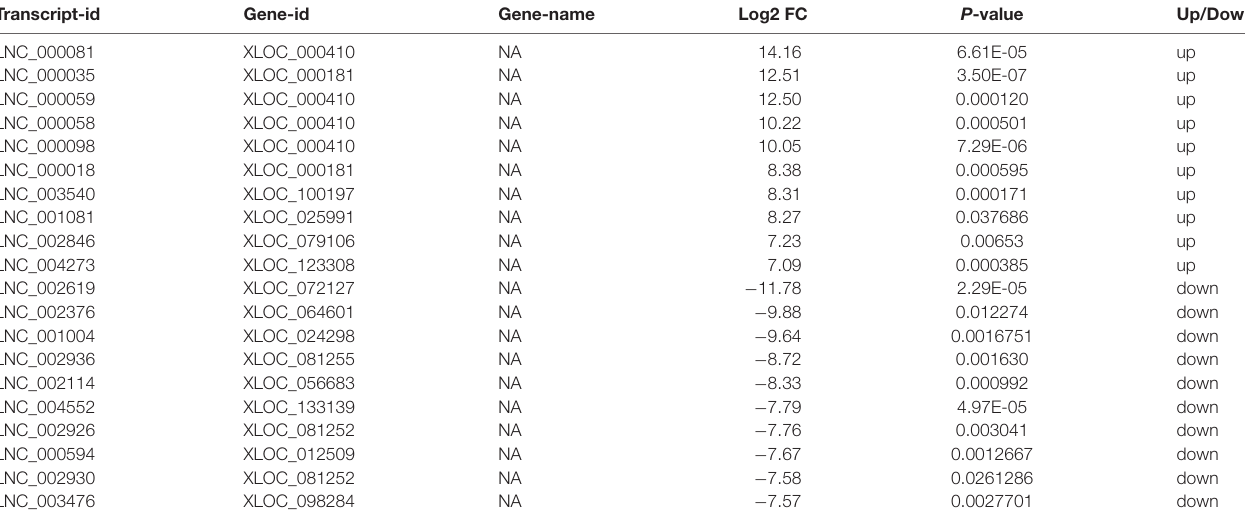
TABLE 3 | Top 10 upregulated and downregulated unknown lncRNAs (patients with AIS vs. healthy